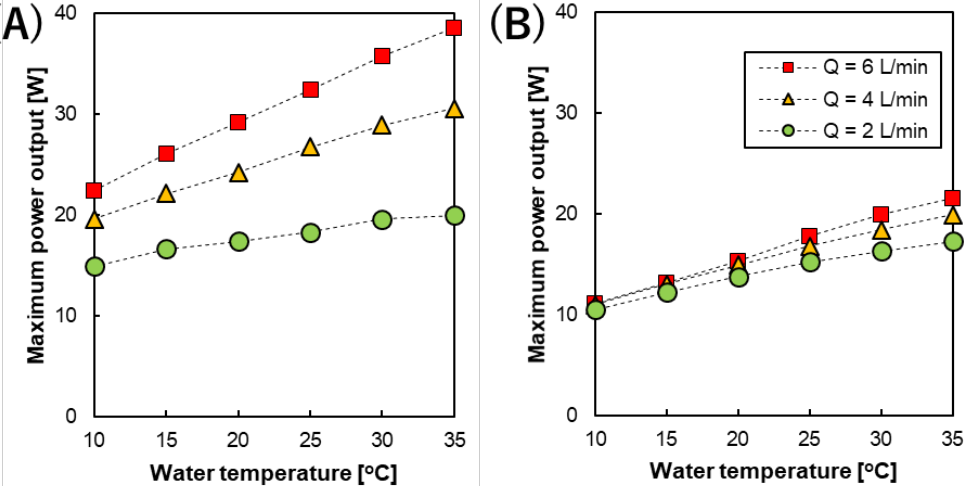
Figure 5. The temperature dependence of the maximum power output of the RED stack with an intermediate distance of ( A ) 200 and ( B ) 600 µm at different feed solution flow rates.